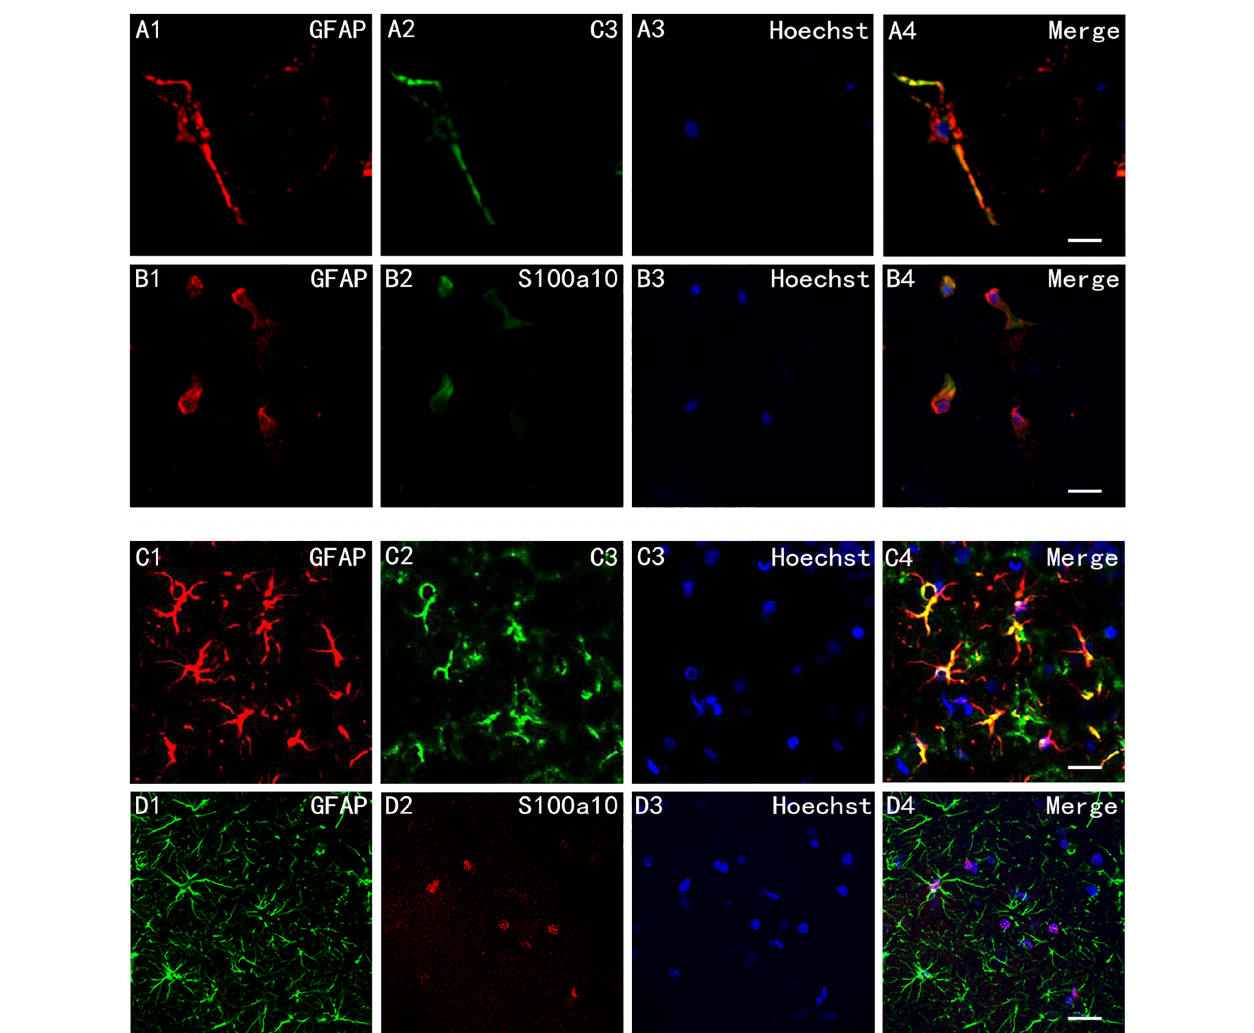
FIGURE 1 | Cell morphology of A1 and A2 astrocytes in vitro and in vivo . (A1–A4) Immunofluorescence staining of cultured astrocytes in vitro after exposure to infrasound for 2 h with glial fibrillary acidic protein (GFAP) and component 3 (C3), and (B1–B4) with GFAP and S100a10. (C1–C4) Immunofluorescence staining of astrocytes in the CA1 region in rats after exposure to infrasound for 3 days with GFAP and C3, and (D1–D4) with GFAP and S100a10. Nuclei stained with Hoechst. Scale bar: 25 µ m.